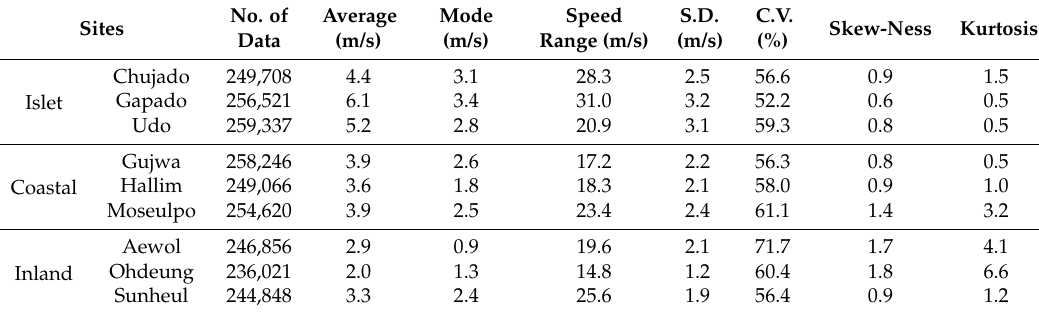
Table 5. Wind speed data characteristics for the three area types.